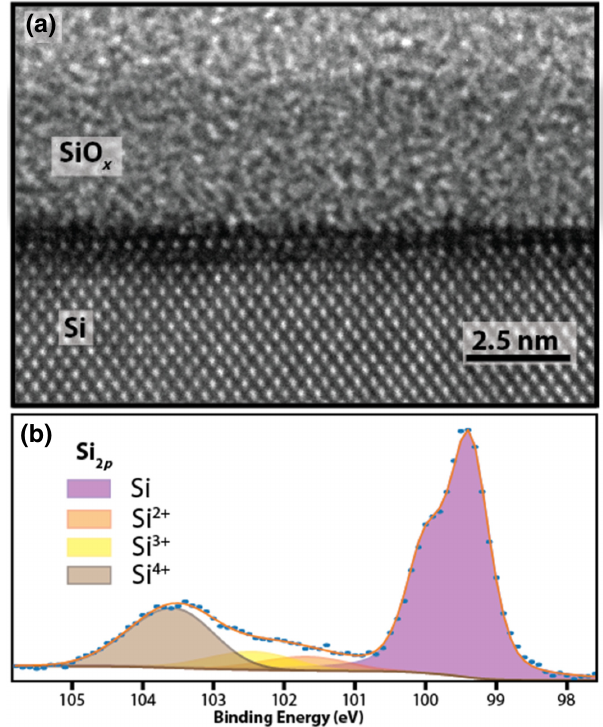
FIG. 4. The silicon substrate-air (SA) interface. (a) A high- resolution TEM image showing the crystalline Si(100) substrate and the amorphous surface oxide. (b) A Si 2 p XPS spectrum, with the Si substrate signal attenuated by the surface